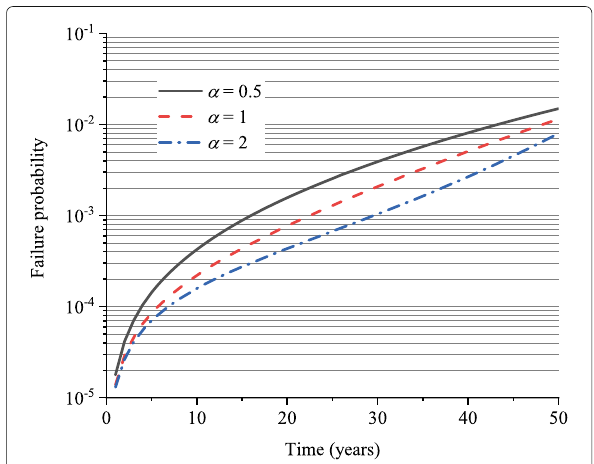
Fig. 6 Dependence of failure probability of a 4-out-of-5 system on deterioration shape with g ( 50 ) =